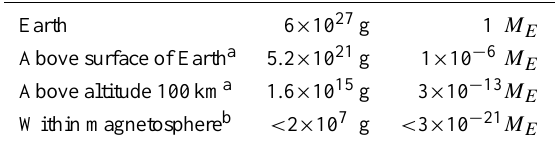
Table 1. Masses in the Earth-ionosphere-magnetosphere